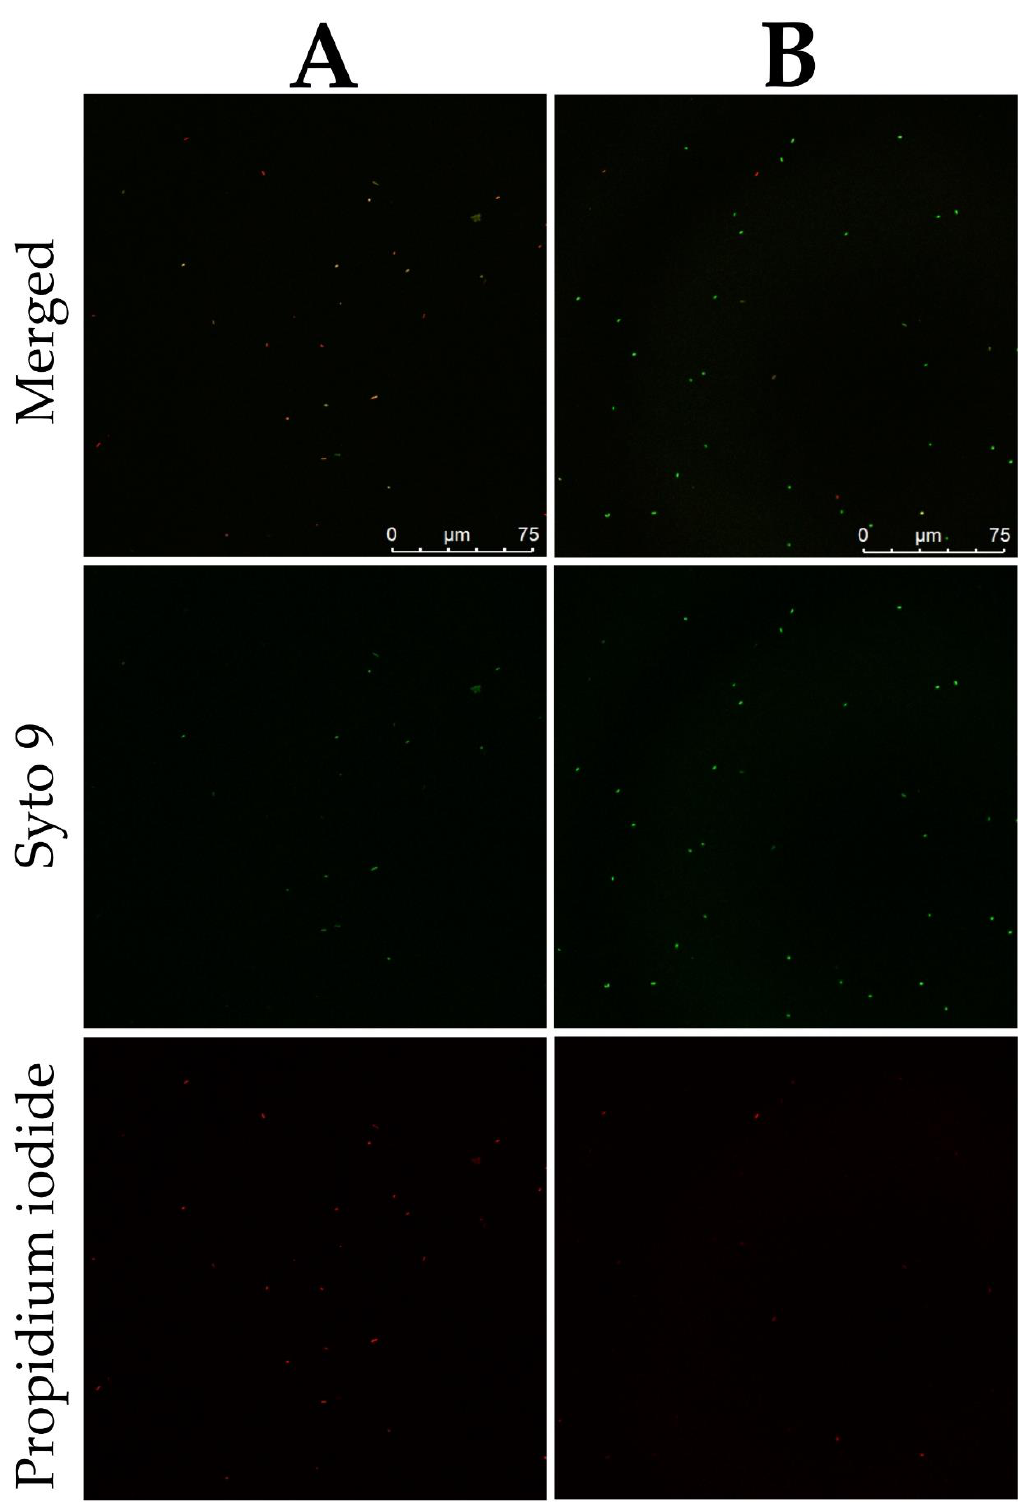
Figure 7. CLSM photomicrographs of D. solani IFB0099 cells subjected to 5-min action of NTAPP ( A ) and the untreated controls ( B ). The LIVE/DEAD BacLight Bacterial Viability Kit (Invitrogen, Waltham, MA, USA) was used for staining. D. solani IFB0099 cells, appearing red due to propidium iodide diffusion through the disrupted cellular membrane, are either dead or substantially damaged. D. solani IFB0099 cells, appearing green due to Syto 9 staining, remain viable. The imaging was performed with a CLSM Leica SP8X (Leica, Wetzlar, Germany) device with a 63× oil immersion lens.